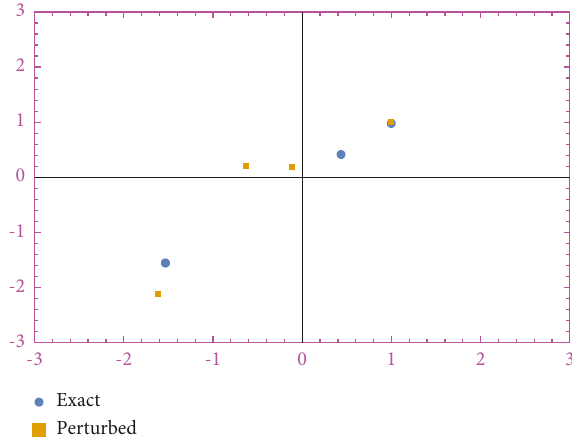
Figure 1: The plots of exact and perturbed